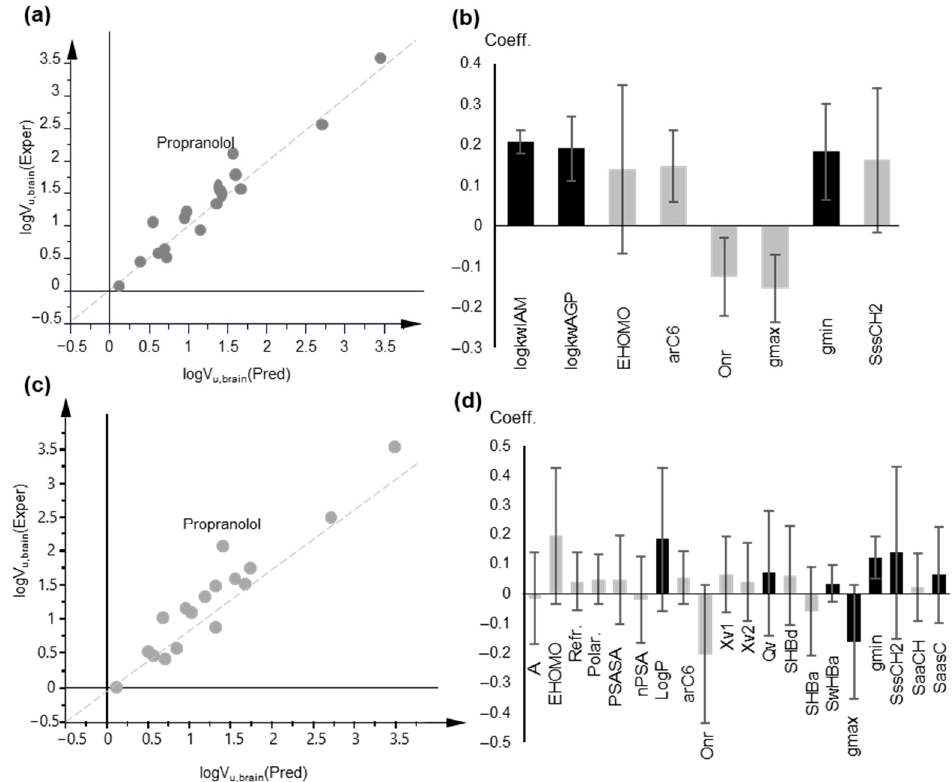
Figure 6. PLS modeling of logV u,brain based on chromatographic data and lipophilicity parameters. ( a ) Observed vs. predicted logV u,brain values plot based on PLS Model 10; ( b ) Coefficient plot of the original variables of PLS Model 10; ( c ) Observed vs. predicted logV u,brain values plot based on PLS Model 11; ( d ) Coefficient plot of the original variables of PLS Model 11; In ( b , d ), variables with VIP > 1 are highlighted in black.